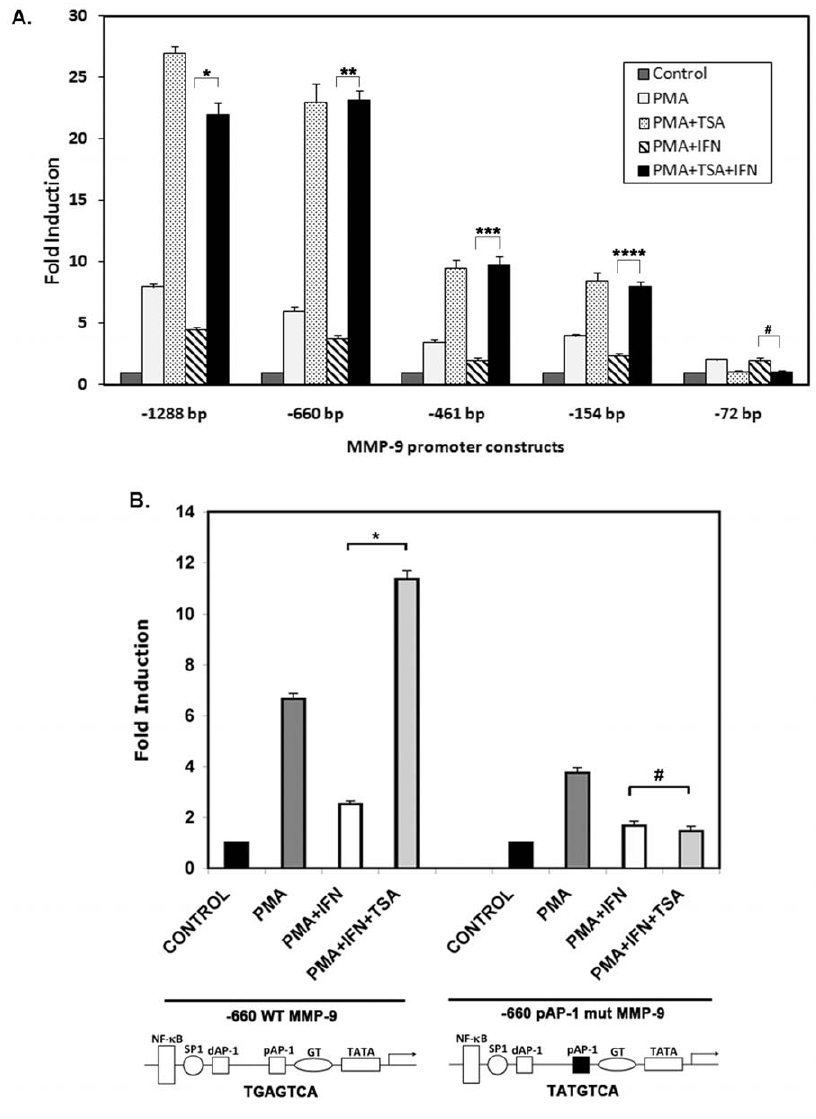
Figure 3. Involvement of HDAC in IFN b mediated repression of MMP-9 promoter. (A) Response of various promoter deletion constructs to a HDAC inhibitor. HT1080 cells were transiently co-transfected with MMP-9 promoter constructs. 24 hours after transfection, cells were pooled and redistributed amongst the wells, so that transfection efficiency was the same for all samples. 48 hours after transfection, the cells were treated with 220 nM TSA, 30 nM PMA and 100 U/mL IFN b as indicated for 18 hours prior to preparation of cell extracts. Cell extracts were assayed for firefly luciferase activities, and normalized by protein concentration to account for any cell concentration differences between samples. Grey bars: untreated, white bars: PMA treated, grey stippled bars: PMA + TSA, hatched bars: IFN b , and black bars: PMA + IFN b + TSA. The P-values were calculated using statistical analysis software. As indicated above bars, *, **, ***, and **** symbols indicate P values that indicate significant difference (0.0011, 0.0009, 0.0007, and 0.0008 resp.) and the symbol # indicates a P value of 0.0874 (no significant difference) with significant values being , 0.01. (B) AP-1 binding to the proximal site is required for HDAC1 recruitment to MMP-9 promoter in response to IFN b . HT1080 cells were transfected in 6-well dishes in triplicates with 2 660 MMP-9 promoter deletion construct containing a point mutation in the proximal AP-1 site, which renders the binding site non-functional, or with wild type 2 660 MMP-9 construct. Cells were prepared as described previously, including treatments with 220 nM TSA, 30 nM PMA and 100 U/mL IFN b for 18 hours prior to preparation of cell extracts. Cell extracts were assayed for firefly luciferase activities, and normalized by protein concentration to account for any cell concentration differences between samples. Black bars: untreated values considered as 1 for each construct, dark grey bars: PMA treated, white bars: PMA + IFN b , and light grey bars: PMA + IFN b + TSA. The experiment was repeated three times and the error bars represent standard deviation calculated from three separate experiments. The P-values were calculated using statistical analysis software. As indicated above the bars, * symbol indicates a P value of 0.0004 (significant difference) and the symbol # indicates a P value of 0.47 (no significant difference), with significant values being , 0.01. doi:10.1371/journal.pone.0042152.g003 treatment condition contained equal amounts of chromatin promoter region surrounding the proximal AP-1 binding site (primers were designed to amplify the region of interest between fragments of the MMP-9 promoter region of interest (Figure 4A, 2 154 bp and + 20 bp). PCR analysis of the control (input) input bands). In untreated cells, p65 association with the MMP-9 indicated that the soluble chromatin samples obtained from each promoter was not detectable. As expected, in PMA treated cells,